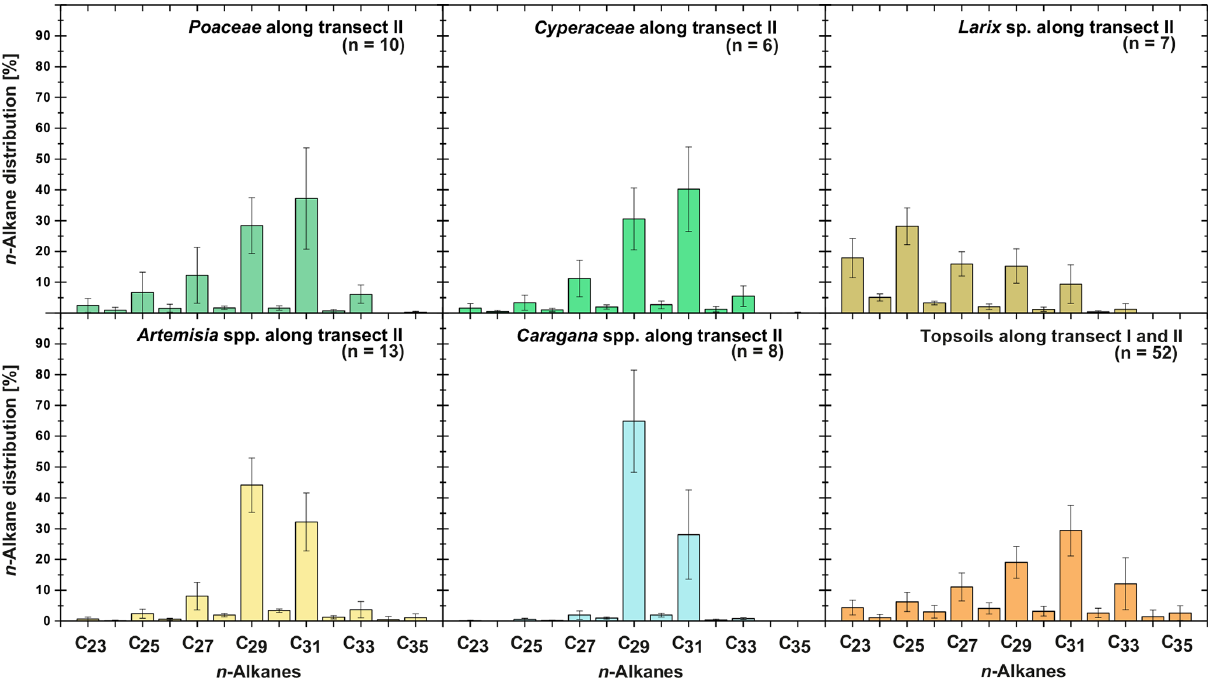
Figure 3. n -Alkane patterns of plants (transect II) and topsoils (transect I and II) from Mongolia. The bars show the mean values ± SD. Table 1. ANOVA p values, indicating differences among plant species and between topsoils and plants for n -alkane pattern and compound- specific δ 13 C ( n -C 29 and n -C 31 ). Bold values indicate significance ( α = 0 . 05). TS is